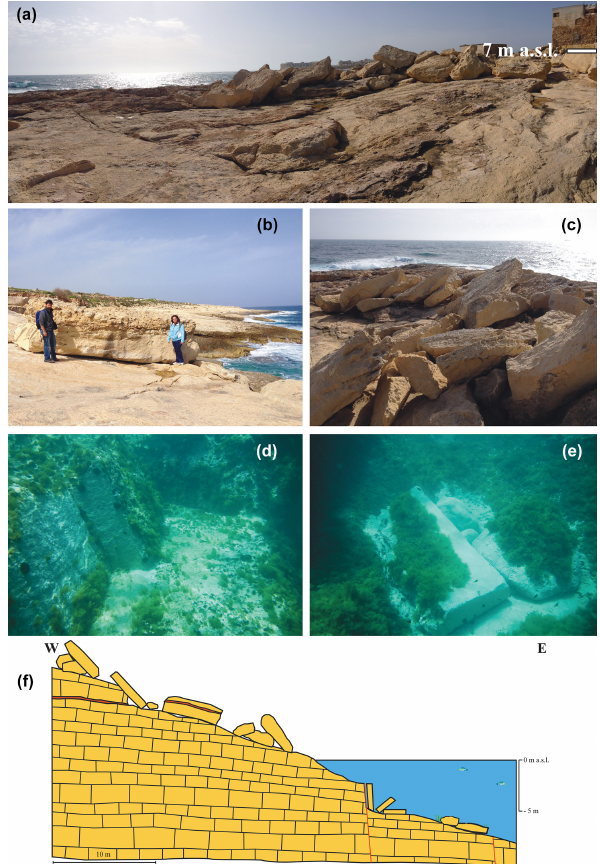
Figure 6. ˙Zonqor: (a, b, c) boulder deposits; (d) underwater fresh detachment surfaces along bedding and fracture planes; (e) sub- merged rectangular and rounded metric boulders; (f) reconstruction of the submerged